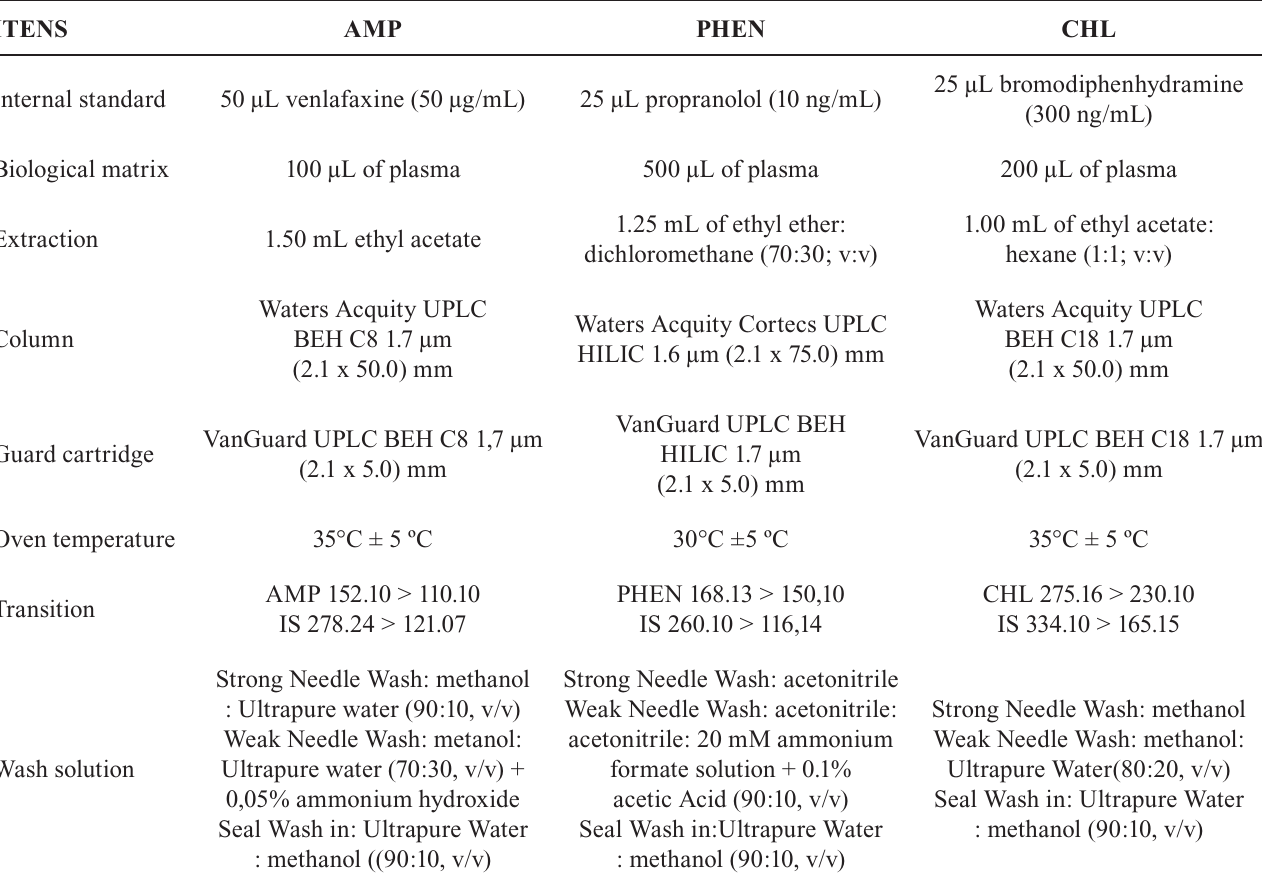
TABLE I - Bioanalytical methods for the drugs acetaminophen, phenylephrine and chlorpheniramine